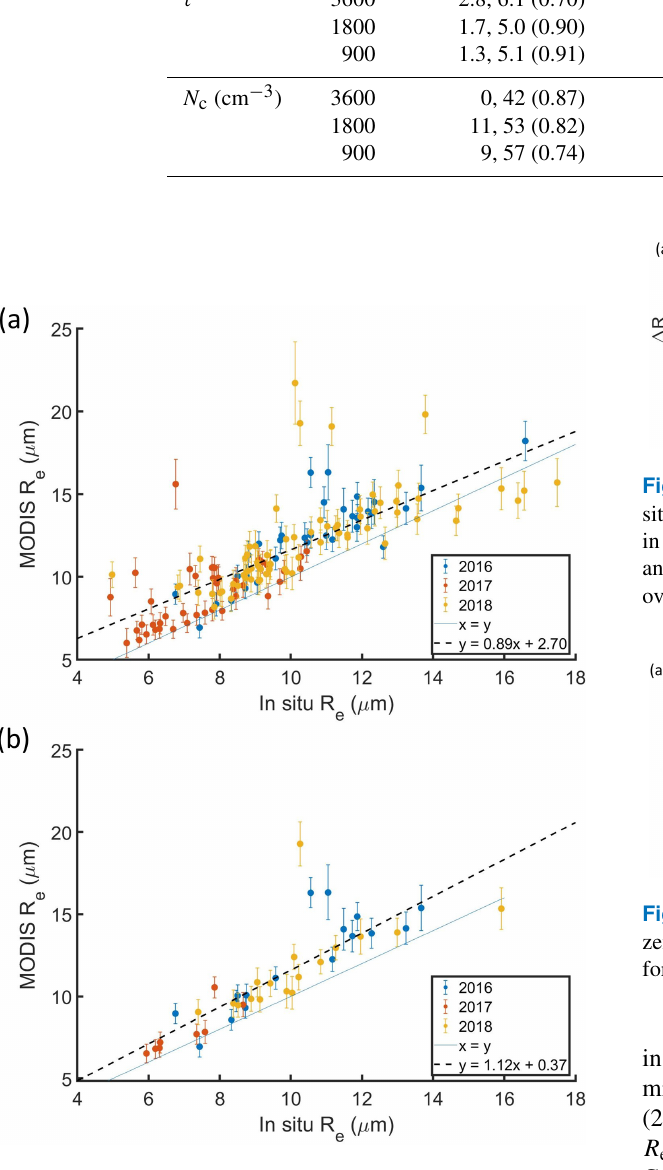
Figure 3. MODIS R e versus in situ R e for profiles with a MODIS retrieval co-located with in situ data for (cid:49)T (a) less than 3600s and (b) less than 900s, colored by ORACLES deployment year. Each point represents a cloud profile with the in situ R e averaged over the top 10% of the cloud and the MODIS R e averaged over a 5 × 5 pixel domain.